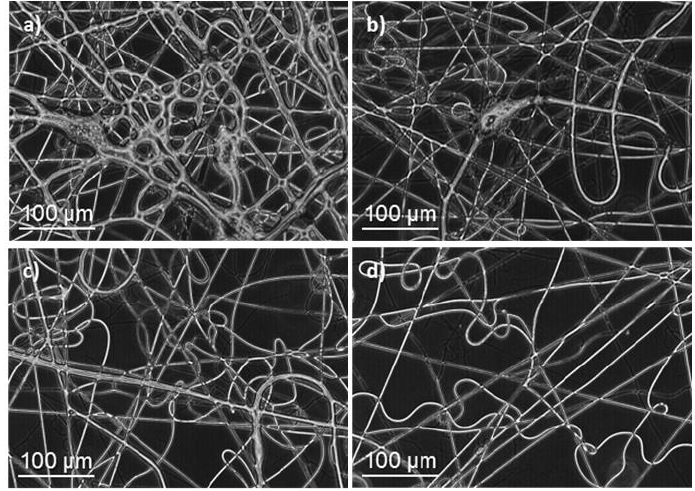
Figure 2. Optical micrographs of (poly(glc-5-glc 6) electrospun samples obtained under the following concentration, flow rate, voltage and needle-collector distance conditions: ( a ) 5% ( w / v ), 1 mL/h, 40 kV, 20 cm; ( b ) 10% ( w / v ), 1 mL/h, 40 kV, 20 cm; ( c ) 20% ( w / v ), 1 mL/h, 10 kV, 12.5 cm; ( d ) 20% ( w / v ), 1 mL/h, 20 kV, 20 cm; ( e ) 30% ( w / v ), 1 mL/h, 20 kV, 20 cm and ( f ) 50% ( w / v ), 4 mL/h, 20 kV, 20 cm.